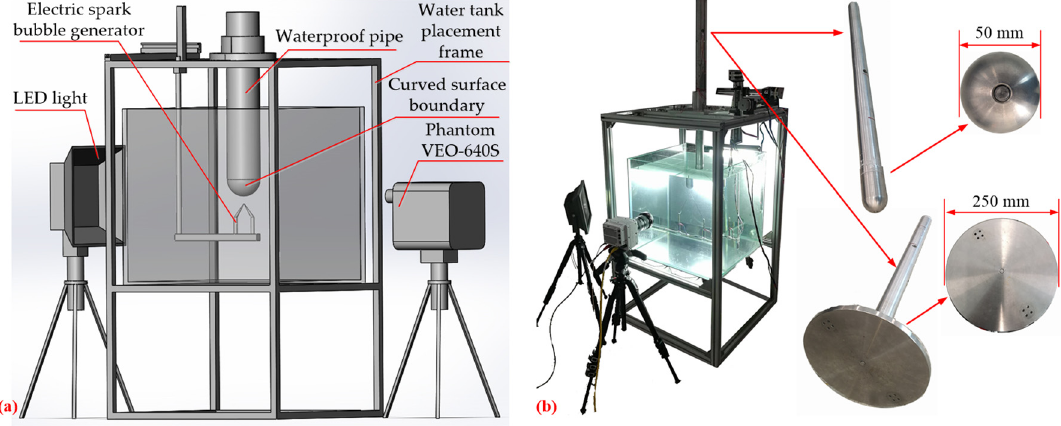
Figure 2. An experimental device for the occurrence and measurement of electric spark bubbles: ( a ) Schematic; ( b ) Real products.